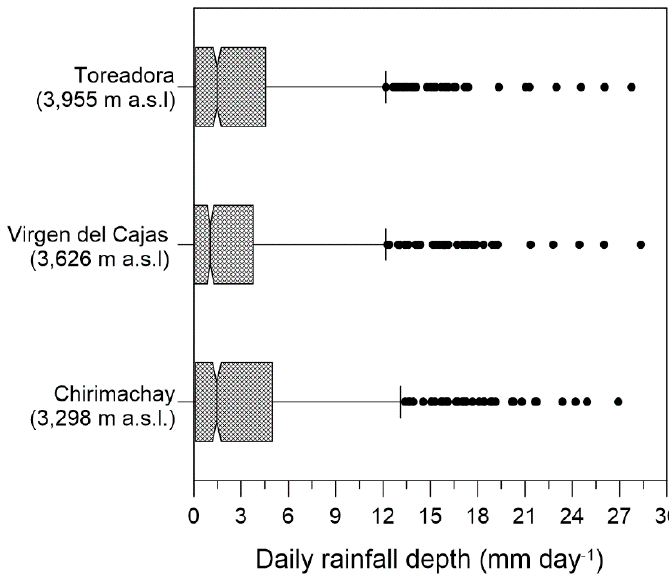
Figure 3. Notched Box ‐ Whisker plot (which displays the population range of the daily rainfall depths, showing respectively the minimum, maximum, median, lower quartile, and upper quartile, and the outliers (black dots).) of the daily rainfall distribution (mm · day − 1 ) in three stations along an altitudinal gradient, for the experimental period of January 2014 to February 2016.